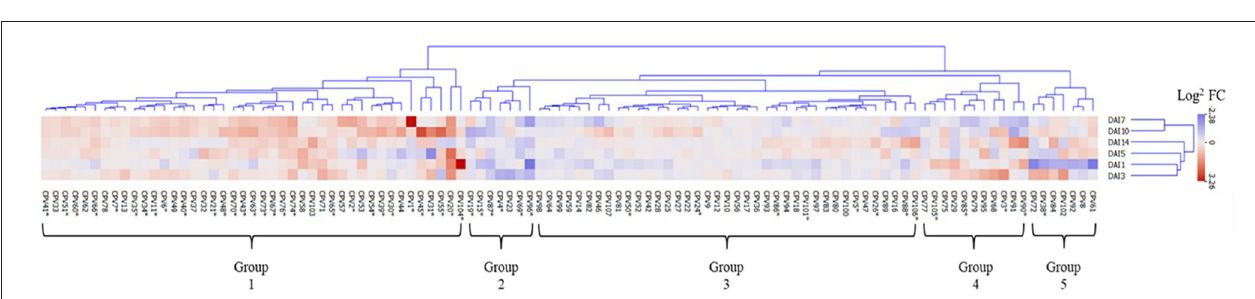
FIGURE 5 | Clustering analysis of 107 CPVs in response to SCN infestation. The heat map was arranged according to CPV log 2 fold change (Infestation/Mock). Five groups were identified, arranged from left to right as elevated, suppressed, no change, and oscillating expression Infested/mock ratios, respectively. Red, blue, and white indicate elevated, suppressed, and no change in expression ratios of volatile emissions. The six rows illustrate the expression patterns of CPVs during the time points 1, 3, 5, 7, 10, and 14 DAI. * indicates statistically significant Infested/Mock ratio (permutation test P <